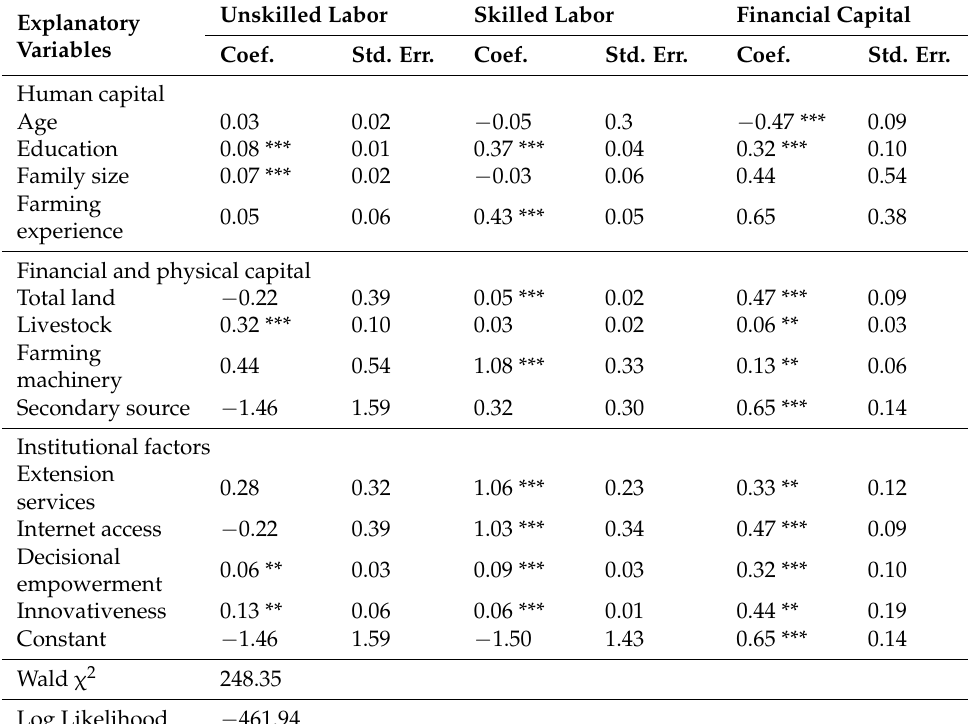
Table 3. Factors affecting adoption of different CSA